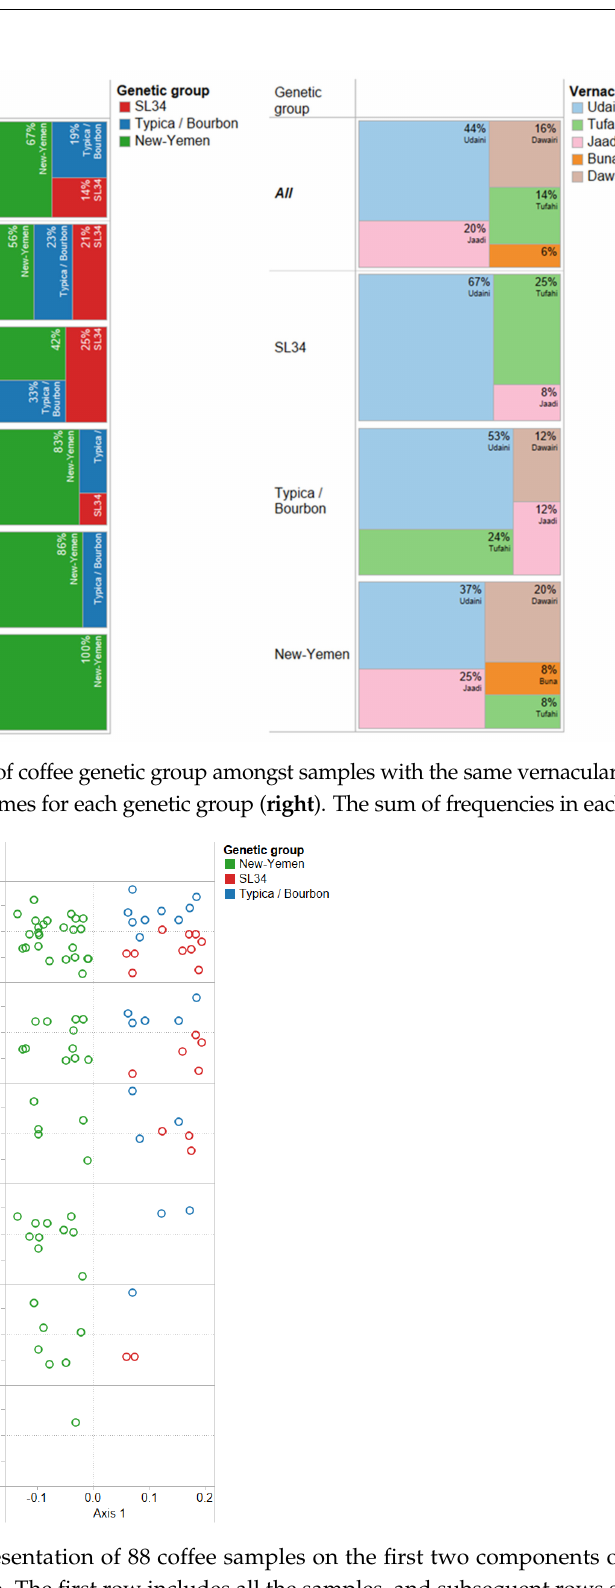
Commented [M38]: Please change the hyphen (-) into minus sign (−, “U+2212”). e.g., “ - 1” should be “−1”. Please use periods as decimal sign instead of com- mas. e.g., “0,1” should be “0.1”. Commented [CM39R38]: Done